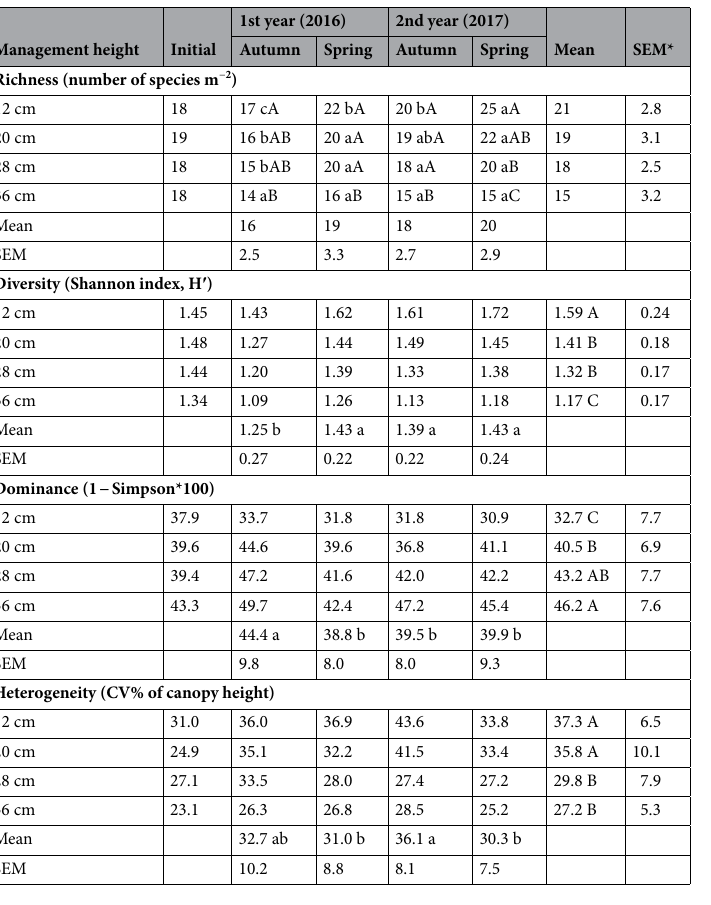
Table 4. Richness (number of species m −2 ), diversity (Shannon index, H ′ ), dominance (1-Simpson index × 100), and structural heterogeneity (coefficient of variance [CV%] of height) per square meter (1 m 2 ) of a Highland grassland dominated by Andropogon lateralis Nees managed under different canopy heights and intermittent stocking grazing during two years of evaluation. *SEM – standard error of the mean. Means followed by the same letters in lowercase (rows) and uppercase (columns) do not differ among themselves at 5%